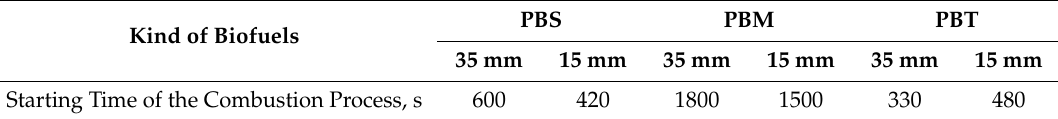
Table 2. Starting time of the combustion